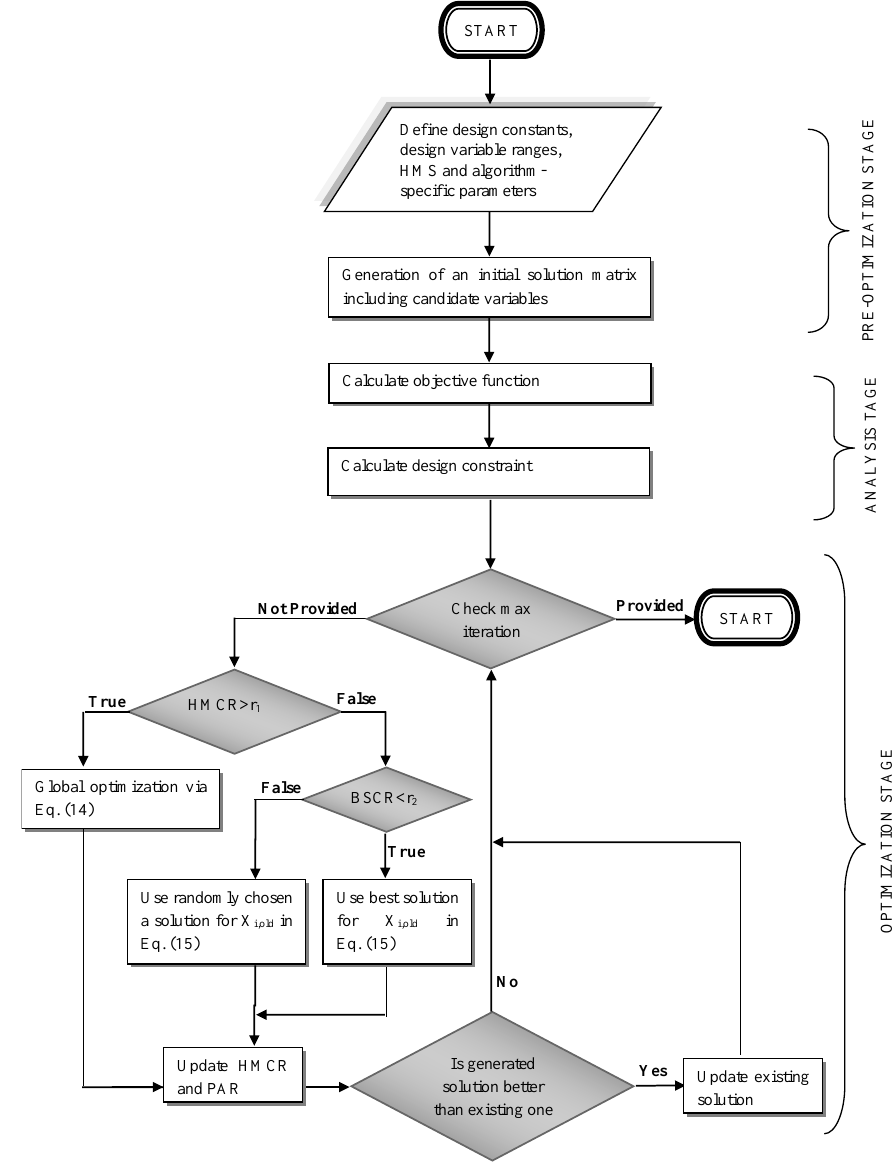
Figure 4. The flowchart of the optimization